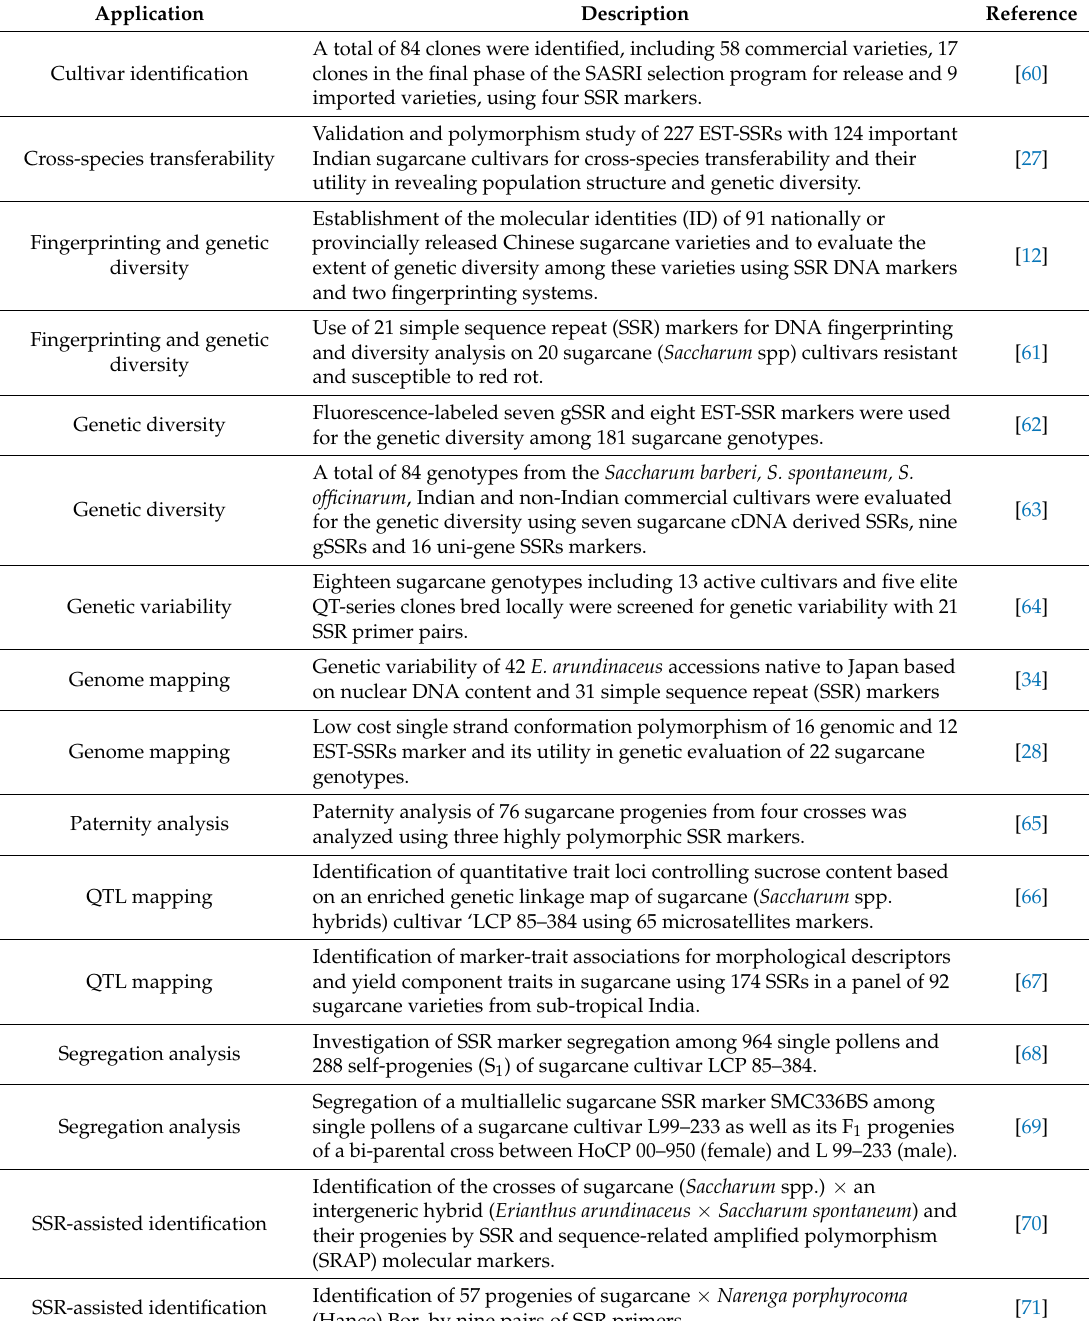
Table 4. Application of SSR markers in sugarcane genetics and